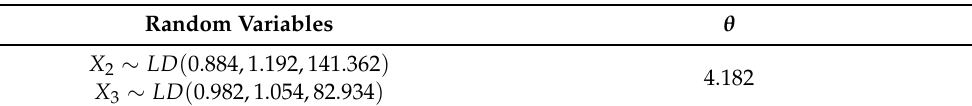
Table 3. MLE for P ( X 2 < X 3 ) .